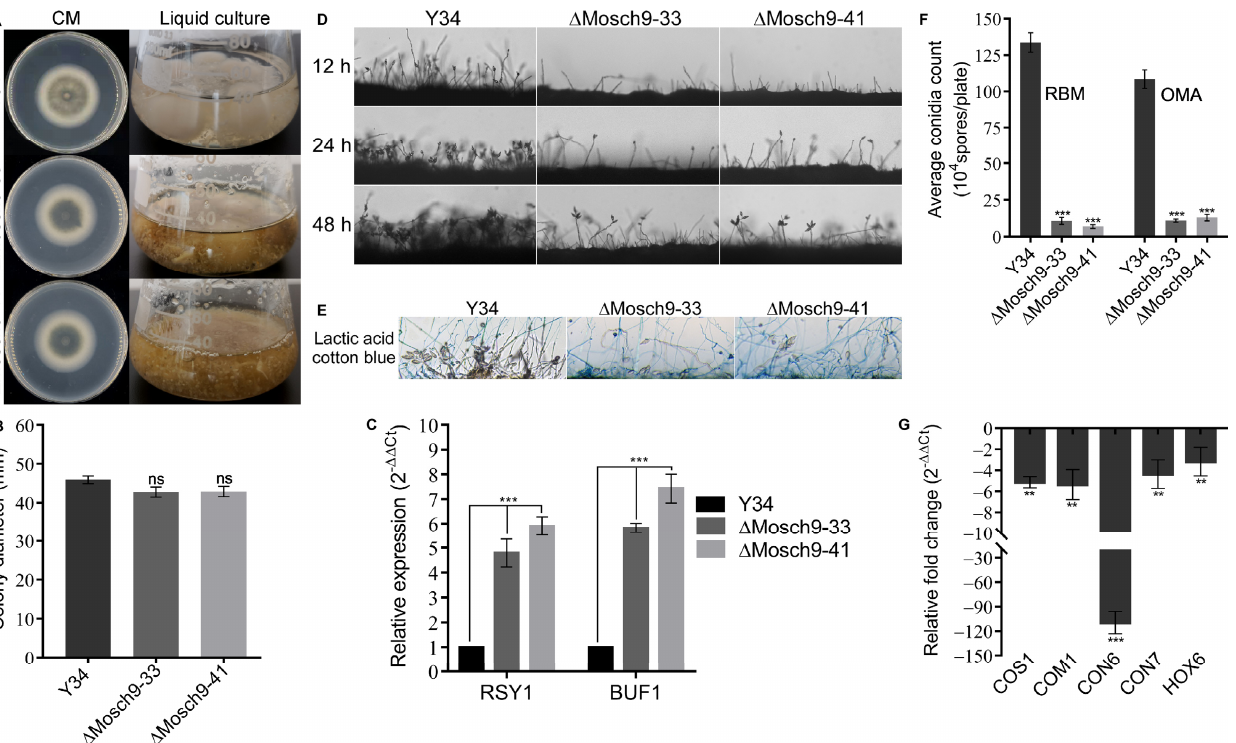
Figure 2. Vegetative growth and conidiogenesis assay. ( A ) Depicts the average colony growth and liquid culture of ∆ Mosch9 mutants compared to wild type on CM media for 7 days. ( B ) Statistical demonstration of the average growth rate of respective wild-type and mutant strains on CM. (ns) represents non-significant difference > 0.05. ( C ) Expression profiling of melanization-responsible genes in respective strain hyphae using qRT-PCR. ( D ) Represents ∆ Mosch9 mutants and wild type conidiophore development and their spore-bearing capabilities on rice bran medium. Bar = 10 µ m. ( E ) Represents Lactophenol cotton blue-stained conidiophore stalks at 48 h. Bar = 20 µ m. ( F ) Statistical data presenting conidiation capability of MoSch9 mutant strains relative to the wild-type strain. ( G ) qRT-PCR analysis of conidiation-responsible genes in MoSch9 mutant strains, taking wild type expression as control (unity = 1). Error bars indicate standard deviation from three independent replicates. (**) and (***) represent significant difference ( p < 0.01 and p < 0.001, respectively) using t